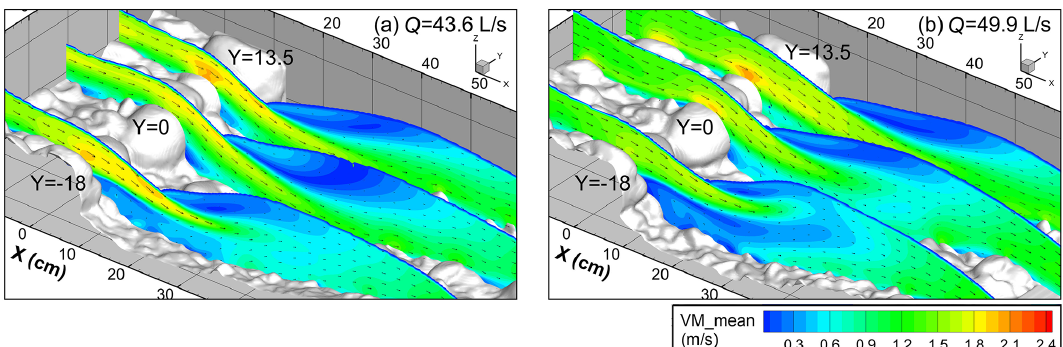
Figure 4. Distribution of time-averaged velocity magnitude (VM_mean) and vectors in three longitudinal sections. The section at Y = 0cm goes across the keystone, while the other two ( Y =− 18 and 13.5cm) are located at the step stones beside the keystone. The spacing for the X , Y , and Z axes is 10cm in the